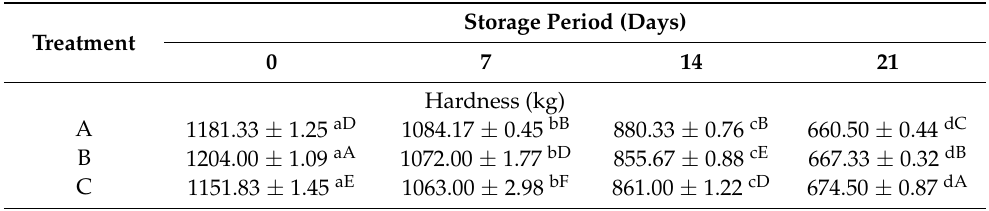
Table 4. Changes in texture profile of fresh cucumber coated with chitosan and/or olive cake extract (OCE) or orange peel extract (OPE) during cold storage (4 ◦